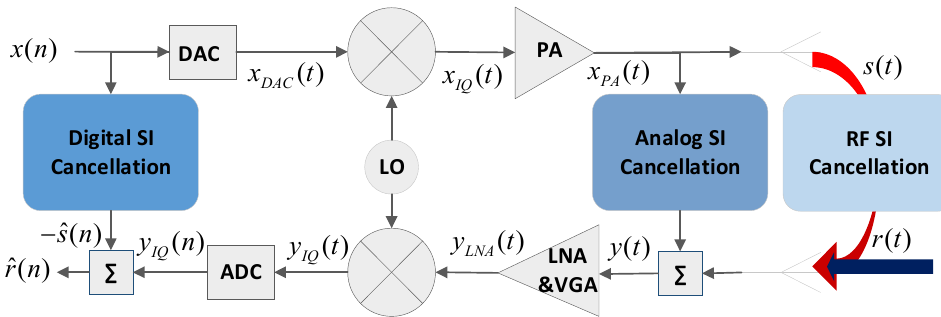
Figure 1. FD transceiver block diagram and associated signals.